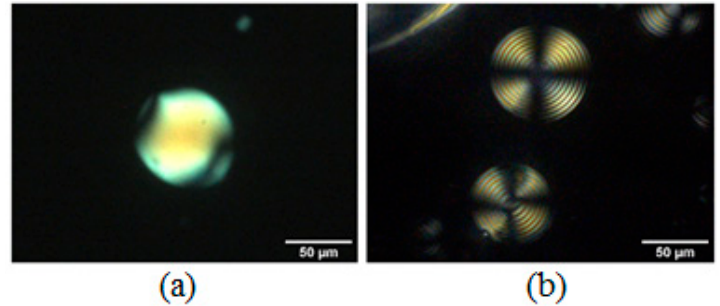
Figure 14. DSCG 13 wt% doped with ( a ) L-lysine 10 wt% and ( b ) trans-Hyp 26 wt%.